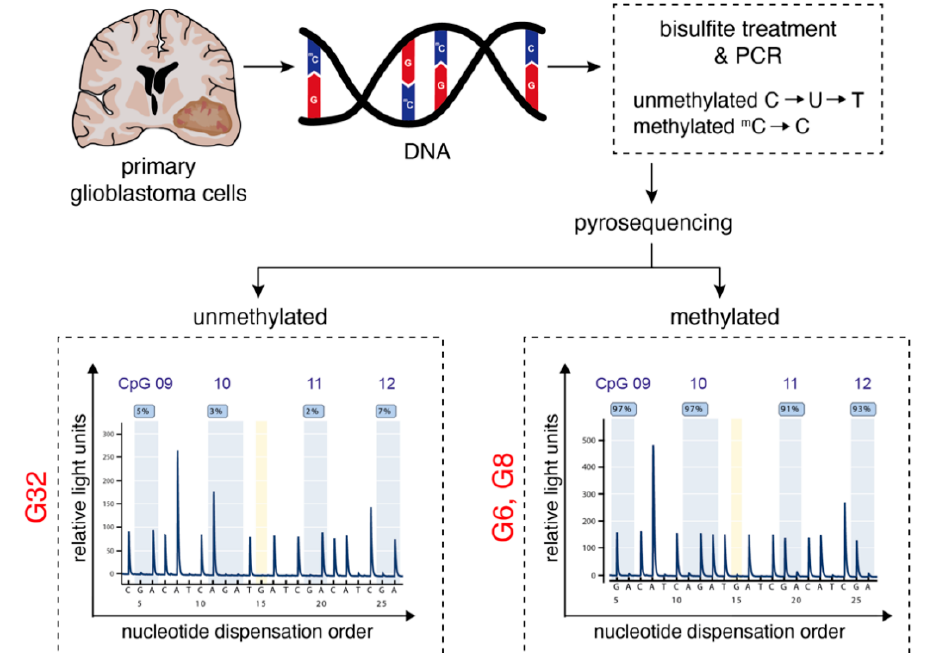
Figure 1. Characterization of human primary glioblastoma cell populations. Workflow illustration of MGMT promoter methylation analysis: Glioblastoma cells were isolated by mechanical disaggregation from surgical specimens obtained from three patients with WHO grade IV astrocytoma. After cell culture was established, DNA was isolated and a pyrosequencing assay was used to determine CpG methylation of the MGMT promoter. The lower panel depicts the methylation level at 4 individual CpG positions for the G32 (left) and G6 (right). Within the program, a guanine signal (G) in this reverse assay indicates the methylated state of the cytosine of the respective CpG dinucleotide, whereas an adenine (A) signal represents the unmethylated state. A, adenine; C, cytosine; CpG, 5 ′ -C-phosphate-G-3 ′ ; G, guanine; MGMT, O-6-methylguanine-DNA methyltransferase; T, thymine; U, uracil.